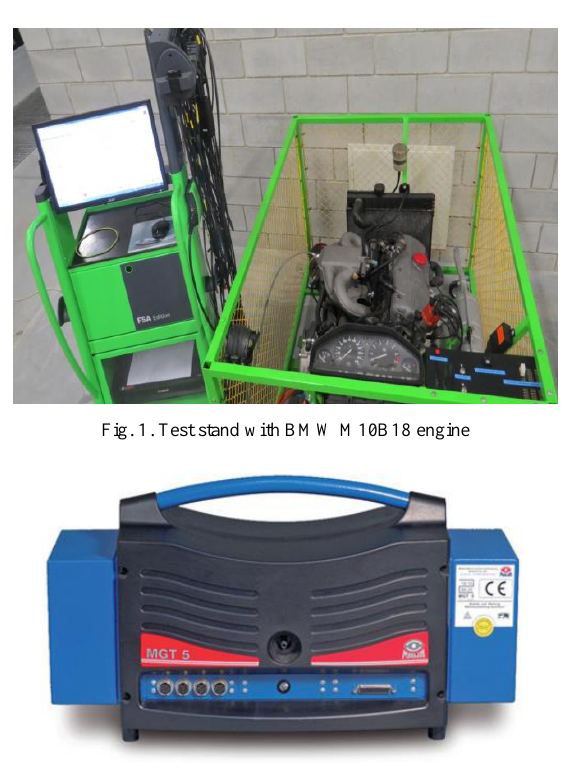
Fig. 2. MAHA MGT 5 exhaust gas analyzer